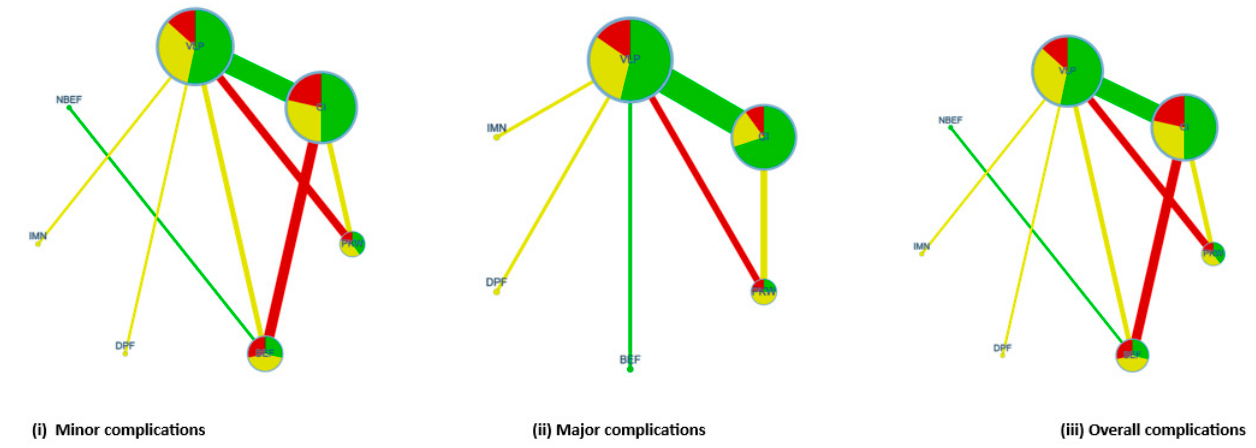
Figure 5. Network geometry for clinical complications.